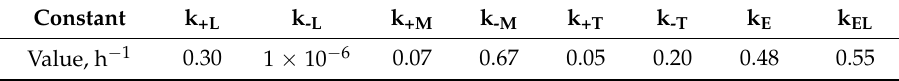
Table 1. The best-fit values of the rate constants k